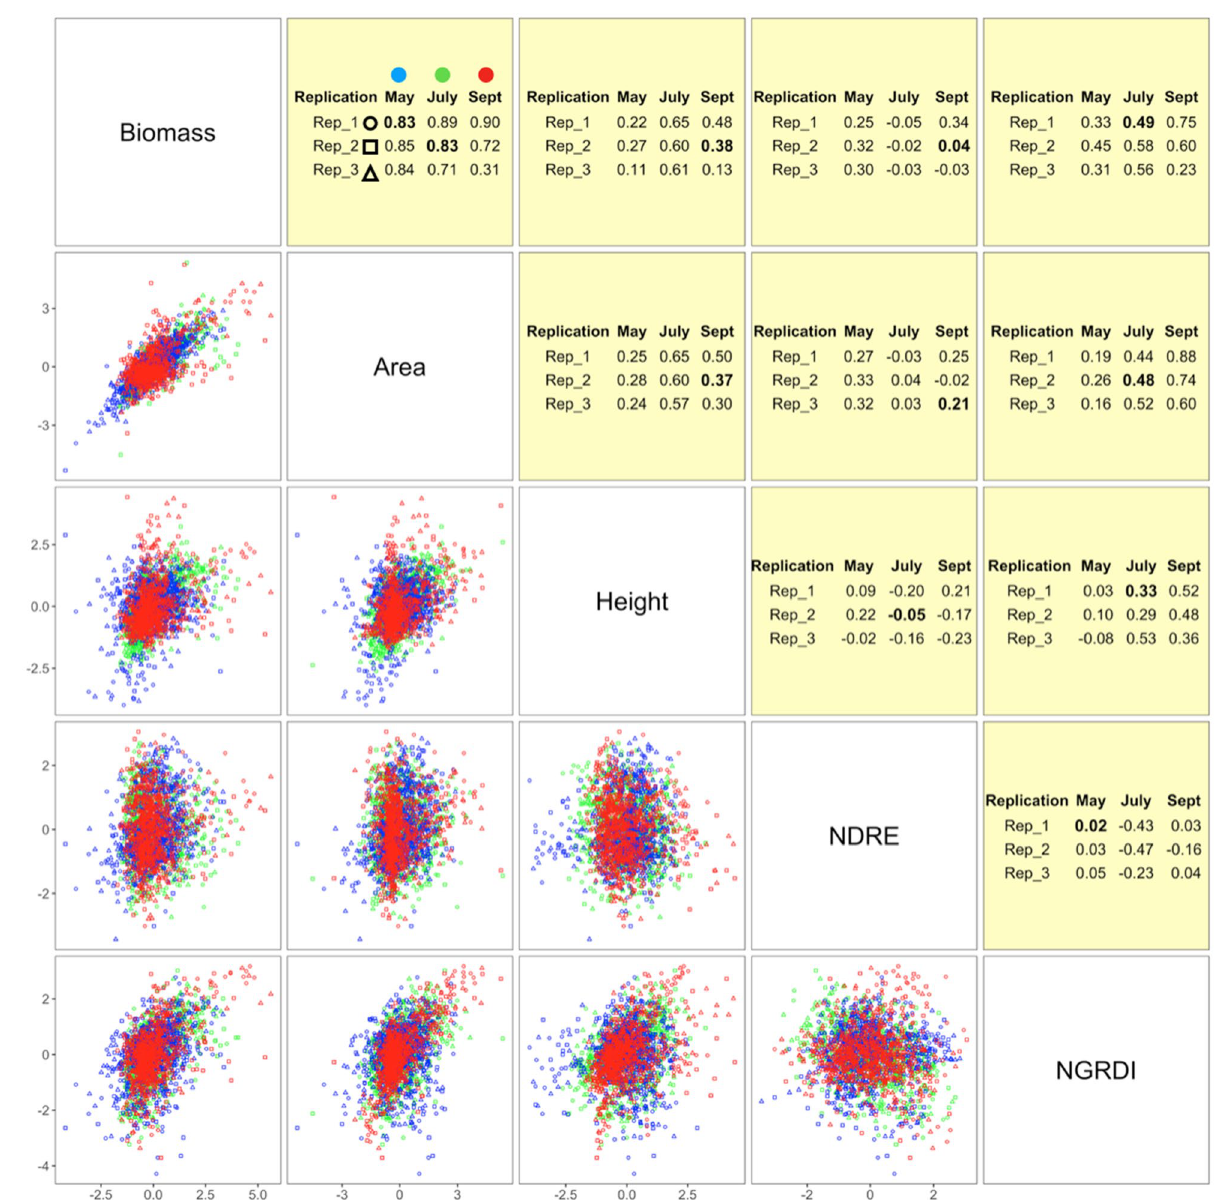
Figure 2. Correlations among biomass and four image features. The correlations of image features with observed biomass are demonstrated as Pearson correlation coefficients in the upper triangular area and scatter plots in the lower triangular area. The four image features are standardized within combinations of month and replicate. The medians of correlation coefficients are highlighted in bold text. Months are illustrated by colors and replicates by shapes. The four image features are canopy area, plant height, Normalized Difference Red Edge (NDRE) Index, and Normalized Green–Red Difference Index R 2 = 0.72 for plots within the nine combinations of replicates and months. Again, the outlier was replicate 3 in September. The biomass in the plots of this combination was not predictable (R 2 = 0.09).